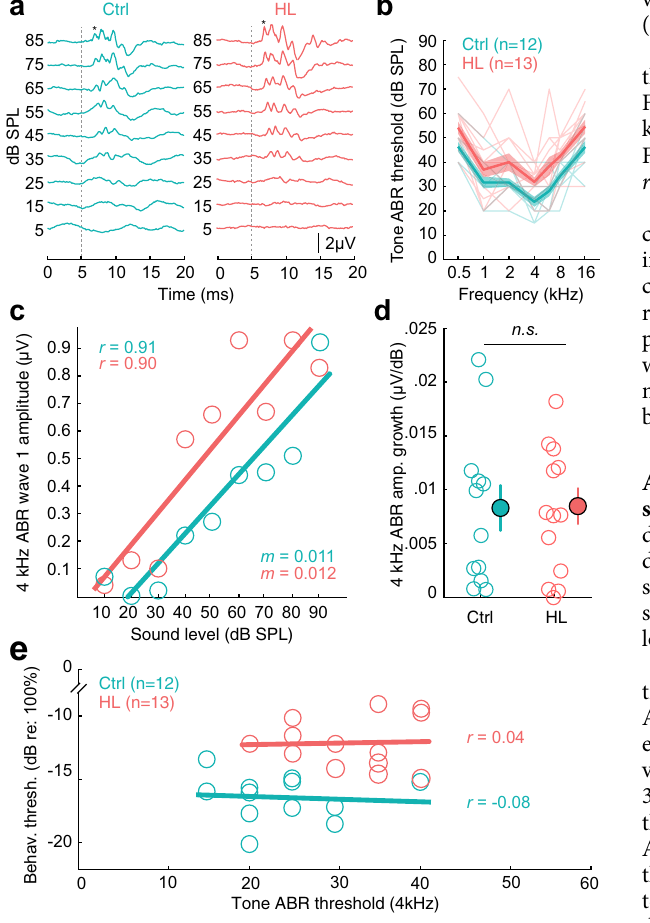
Fig. 8 Control experiment: HL-related AM detection de fi cits are not due to status of auditory periphery. a Auditory brainstem response (ABR) waveforms in response to 4kHz tone pips for example control (Ctrl, Subject ID: M274129) and HL-reared animal (HL, Subject ID: M274131). Vertical dotted line indicates stimulus onset. Asterisk (*) indicates ABR wave 1. b Tone ABR Thresholds (mean ± SEM) as a function of frequency (kHz). c 4kHz ABR wave 1 amplitude ( µ V) as a function of sound level (dB SPL) for two example Ctrl and HL animals. Solid line indicates linear fi t; m indicates the slope of the fi t. Pearson ’ s r value for each regression are noted on the top left corner. d There are no signi fi cant differences in the 4kHz ABR wave 1 amplitude growth ( µ V/dB) between Ctrl and HL-reared animals ( p = 0.87, one-way ANOVA). Amplitude growth values are calculated from the slope of the linear regression to wave 1 amplitude with sound level (i.e., in c ). Open circles indicate individual values from Control ( n = 12) and HL ( n = 13) animals, and closed circles with associated error bars indicate group mean ± SEM. e Individual behavioral threshold as a function of ABR threshold at 4 kHz. Behavioral thresholds were from the fi nal day of psychometric testing, closest to when the ABR was collected. Solid line indicates fi tted linear regression. Horizontal linear fi ts indicate no correlation (Pearson ’ s r ≤ 0.04 for both groups) between tone ABR thresholds and behavioral